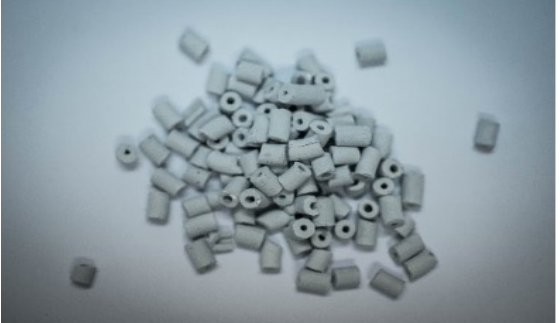
Figure 10. A rod shape with 2 mm pore dimeter of Pd/Al 2 O 3 catalyst used throughout the experiment.